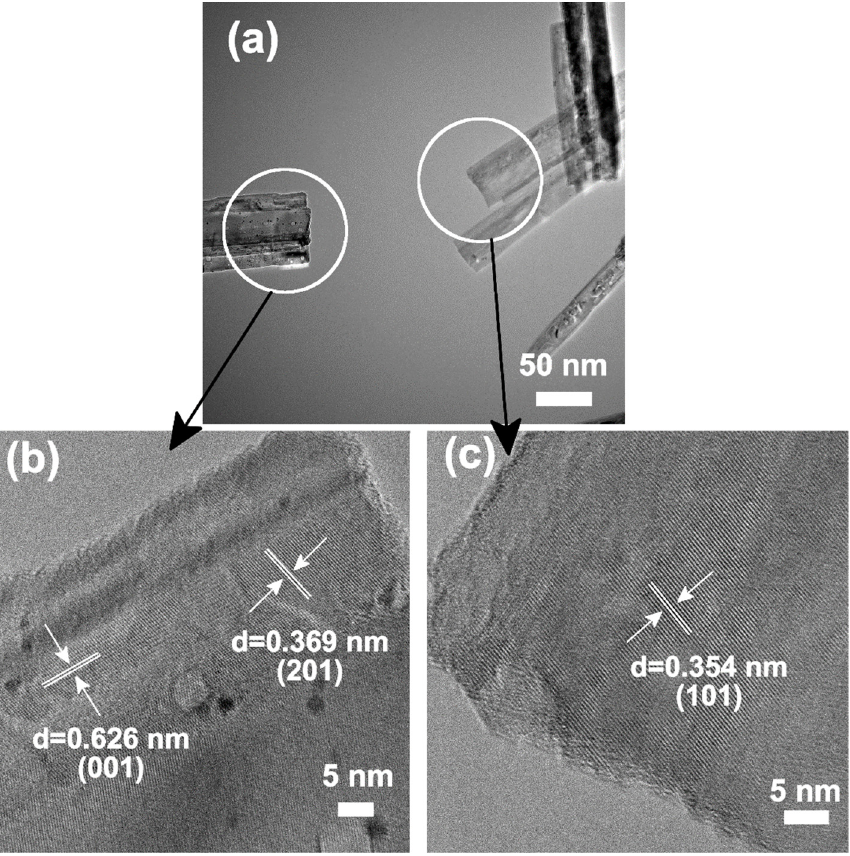
Figure 5. ( a ) TEM images of Pt-deposited TiO 2 MP sample (with 1.2 wt% Pt 4+ loading amount). HRTEM images of ( b ) brookite TiO 2 nanofibers and ( c ) anatase TiO 2 nanofibers. HRTEM images of ( b ) brookite TiO 2 nanofibers and ( c ) anatase TiO 2